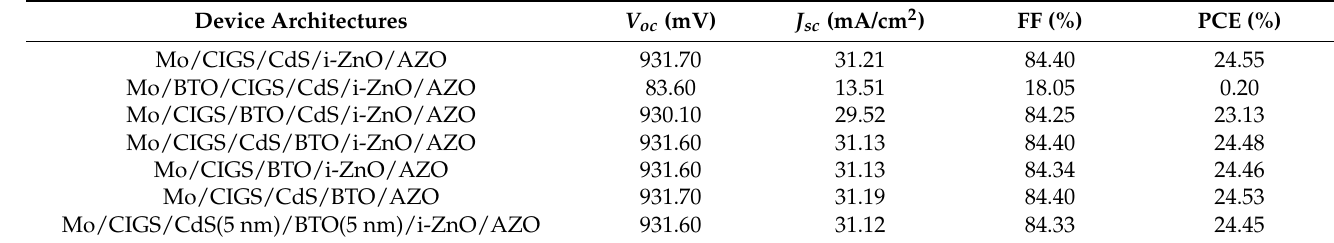
Table 2. The simulated device parameters for PV devices with different device